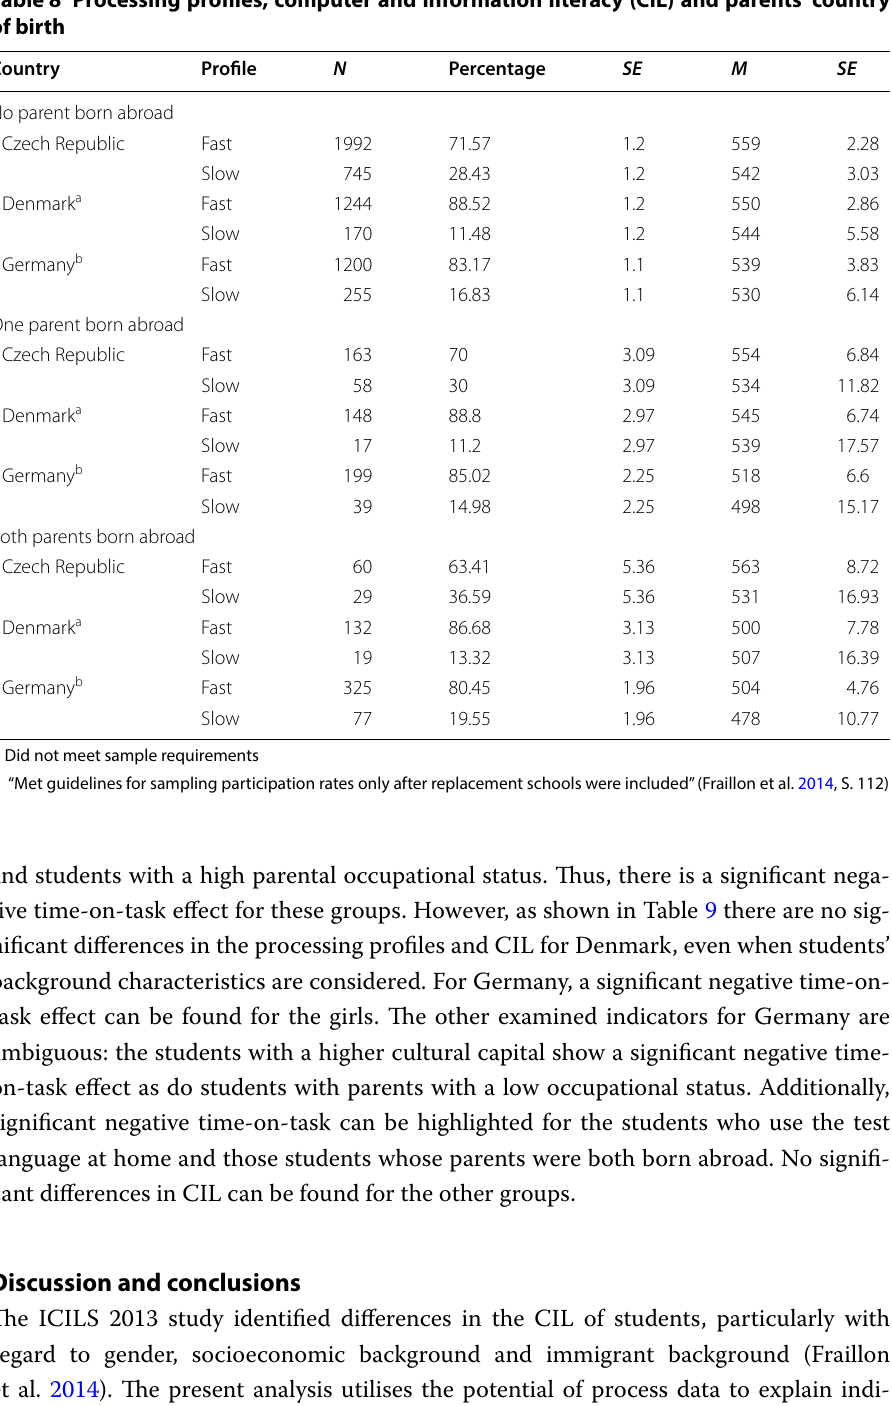
Table 8 Processing profiles, computer and information literacy (CIL) and parents’ country of birth